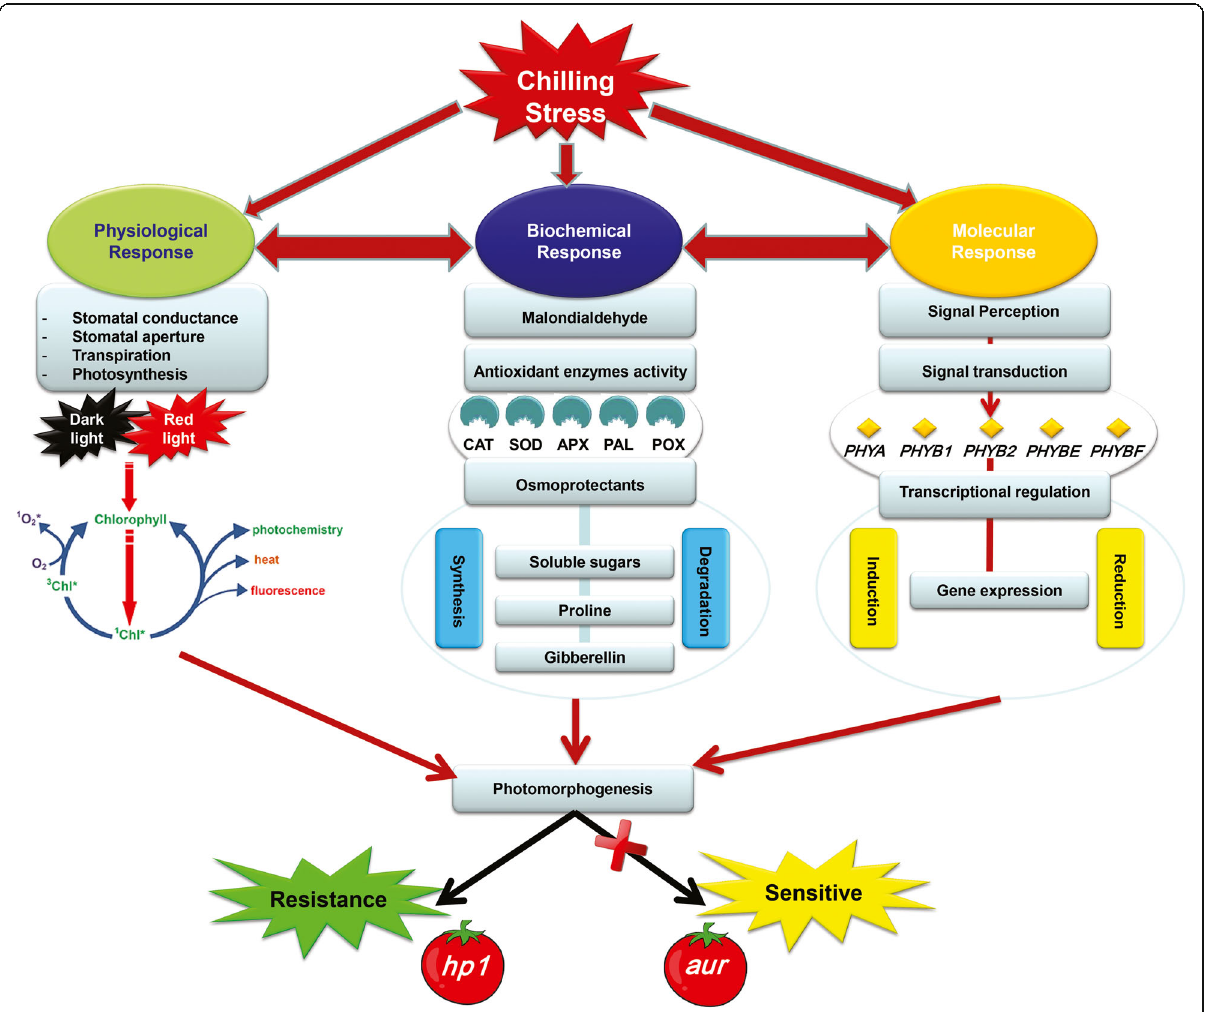
Fig. 9 A schematic diagram showing divergent regulatory mechanisms of phytochrome-sensitive and phytochrome-deficient tomato mutants